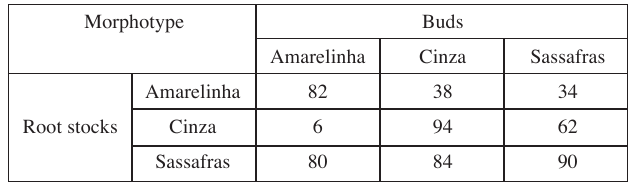
Tab. 1: Survival rate (%) of grafted maté plants produced from different com- binations of root stocks and buds of the phenotypes